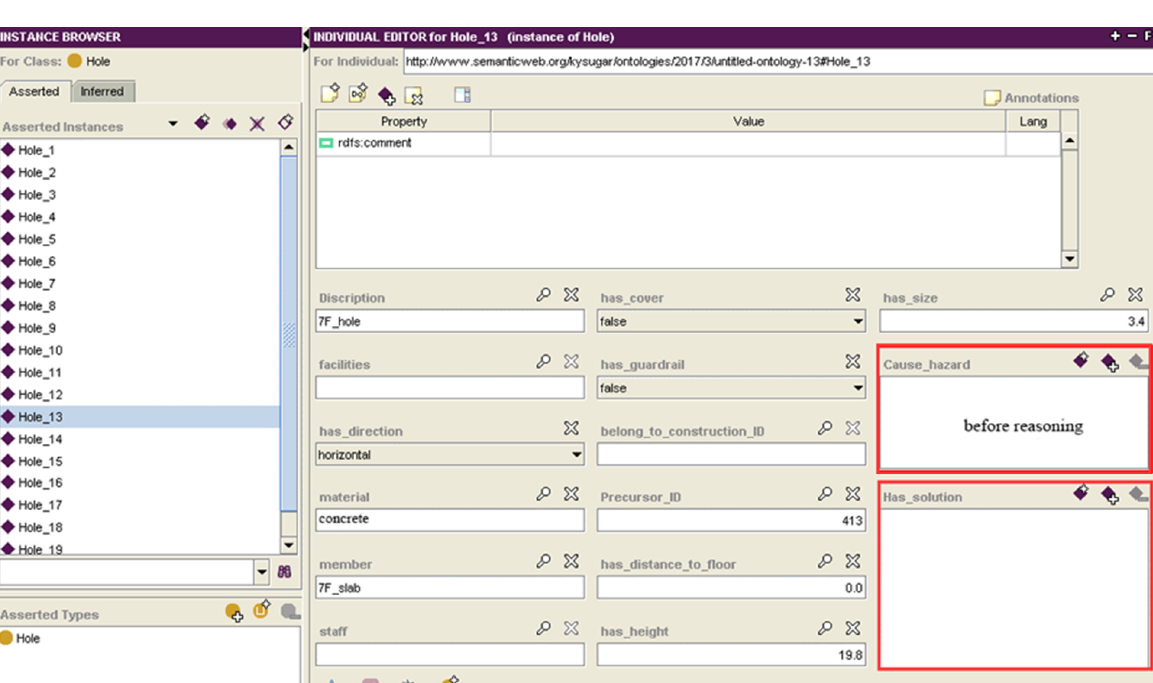
Figure 18. Top floor stair opening.